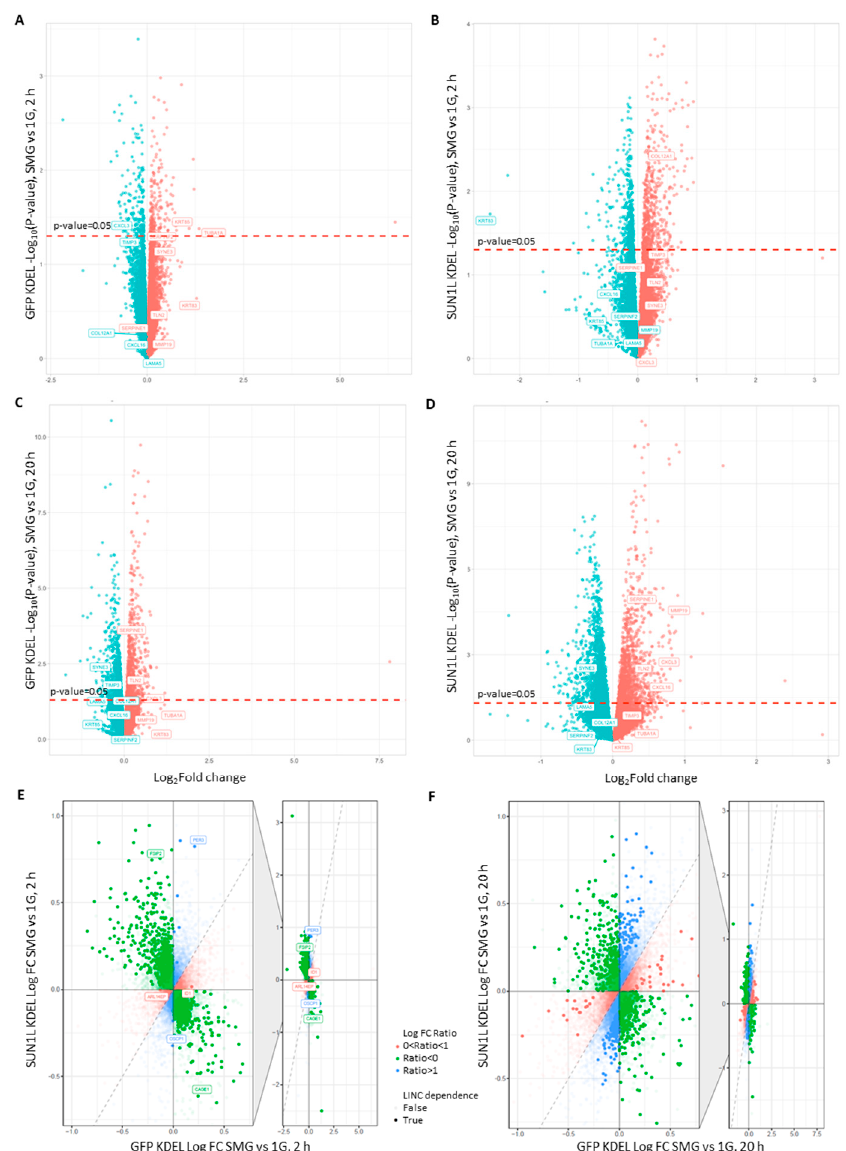
Figure 2. Transcriptome responds to SMG and varies upon LINC disruption at di ff erent exposure times. Volcano plots of di ff erentially expressing genes between SMG and 1G with statistical significance in the y -axis and fold change on the x -axis in ( A ) GFP-KDEL cells after 2 h, ( B ) SUN1L-KDEL cells after 2 h, ( C ) GFP-KDEL cells after 20 h, ( D ) SUN1L-KDEL cells after 20 h. Upregulated genes are shown in orange and downregulated genes are shown in blue. Significantly di ff erentially expressing genes with p ≤ 0.05 are above the red dashed line. ( E , F ) summarize all the LINC-dependent genes identified through the interaction model at 2 and 20 h, respectively, which are described in Supplementary Tables S3 and S6. The whole distribution is shown to the right with the indicated area magnified on the left. Genes with statistical significance ( p < 0.05) are shown to be di ff erentially regulated under the interaction of LINC disruption and SMG conditions and are highlighted with LINC dependence equal to True in the figure. Genes that are not highlighted (False) did not attain significance and are not dependent on LINC. For each gene, the log fold-change (logFC) for response to SMG vs. its 1G control in the SUNL-KDEL cells is divided by the same characterization but in the GFP KDEL controls and is color-coded on the plot. Based on this logFC ratio, these genes could be characterized as being regulated in the opposite direction for each cell line (green, Ratio < 0), regulated more strongly under the SUN1L KDEL cell line (blue, Ratio > 1) or regulated more strongly under the GFP cell line (pink, 0 < Ratio < 1).